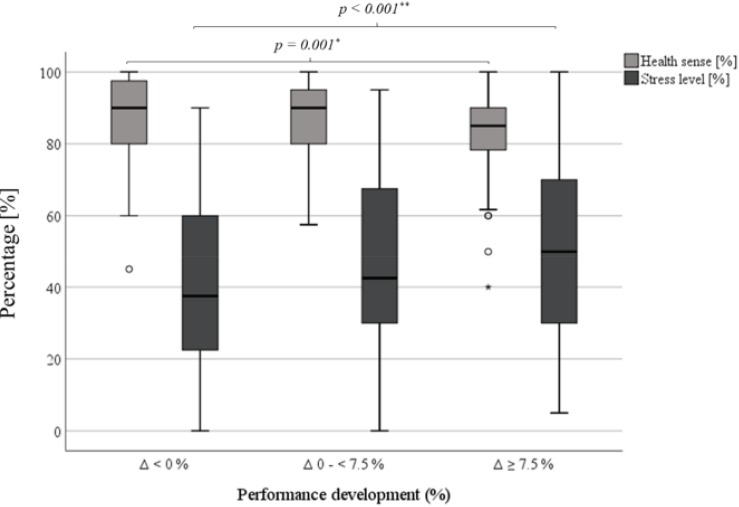
Health senses and stress levels dependent on performance development (total cohort). Δ = delta Paerob V1 vs. Paerob V2. ∗∗p < 0.001, ∗p < 0.01.